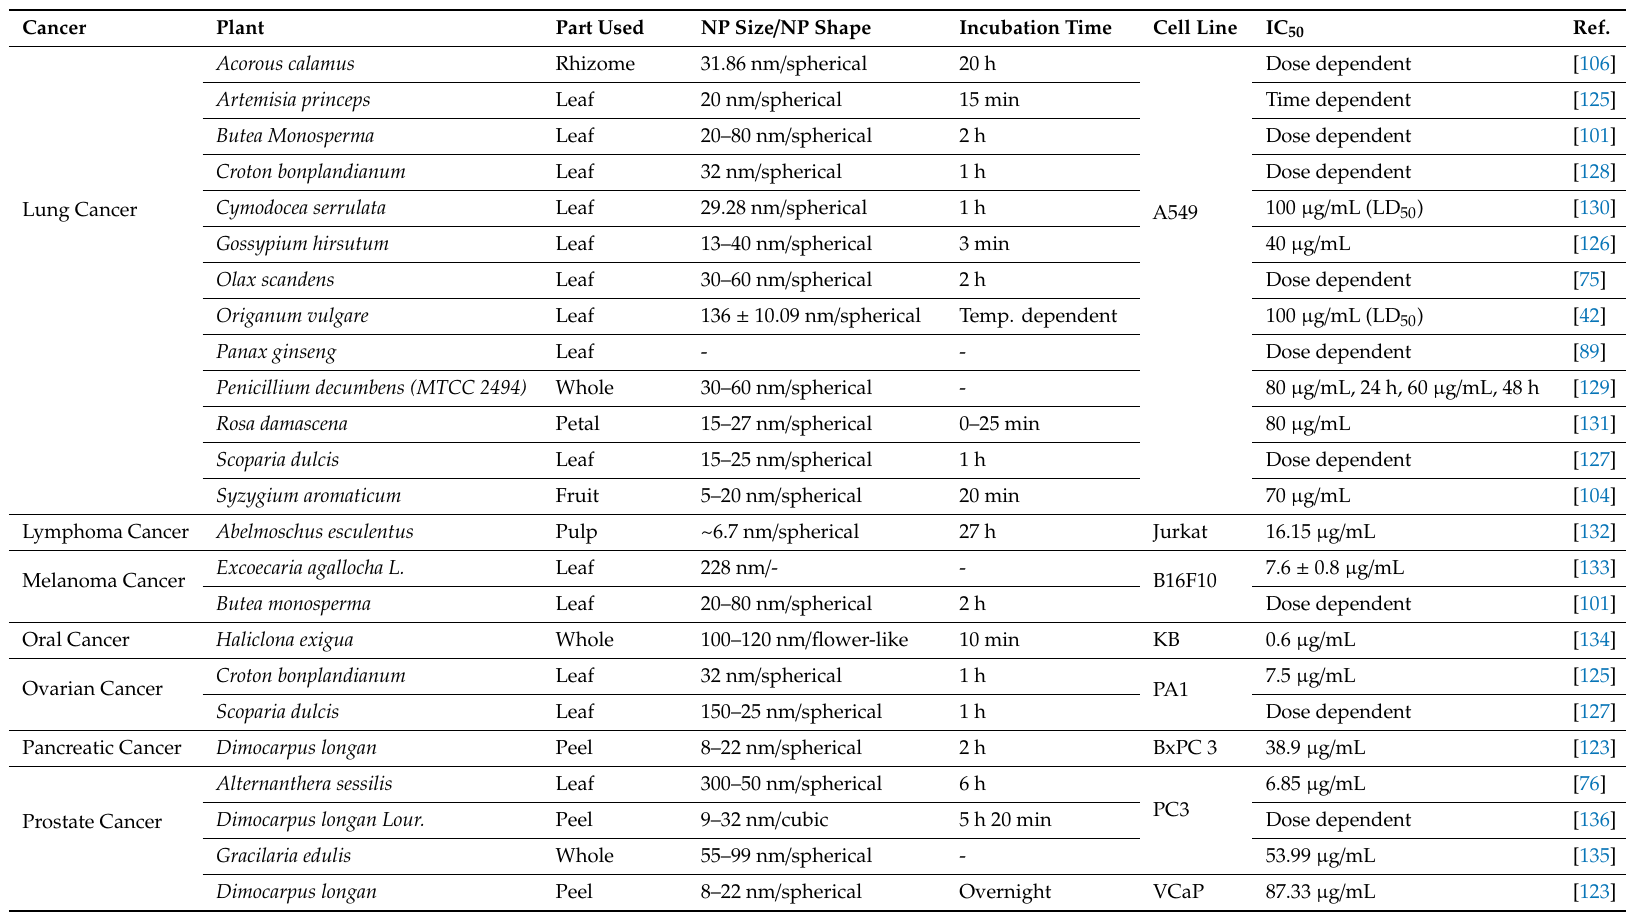
Table 5. List of studies using plant extracts for the biosynthesis of AgNPs that inhibited cell lines of lung cancer, lymphoma, melanoma, oral cancer, ovarian cancer, pancreatic cancer and prostate